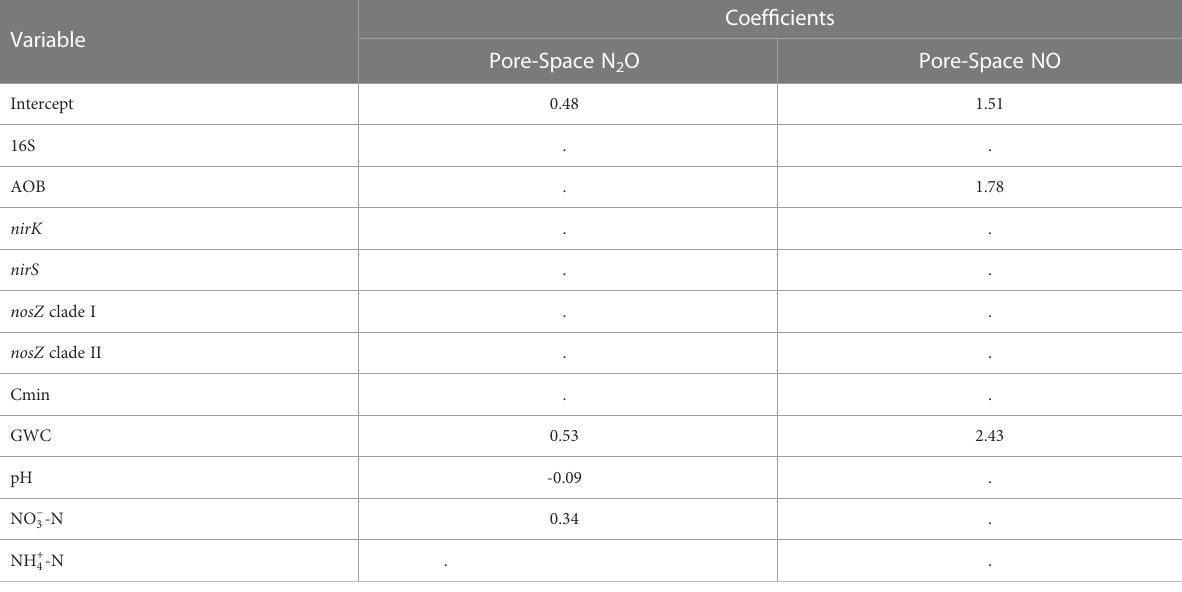
TABLE 2 Model coef fi cients for LASSO regression analysis of pore-space N 2 O and NO concentration. Variable Intercept 0.48 1.51